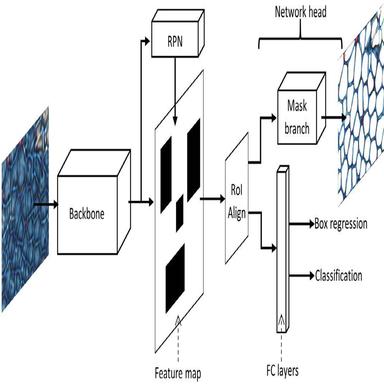
A schematic of the mask R-CNN architecture.